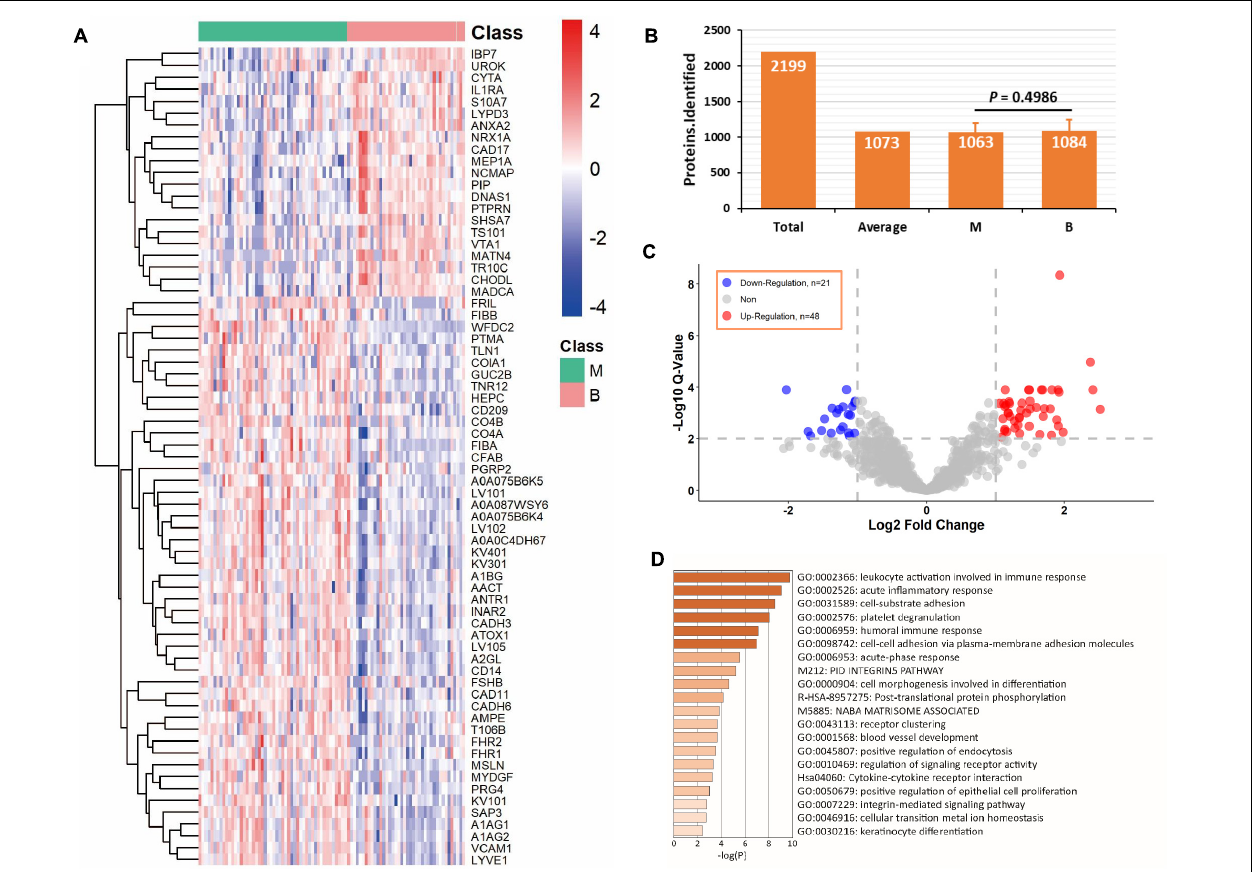
FIGURE 3 | Analysis of differentially expressed proteins in C1 dataset. (A) Differentially expressed proteins in benign and malignant groups with q -value < 0.01 and absolute log2 fold change > 1. (B) Average protein identification numbers in each sample, benign and malignant groups of C1 dataset. (C) Volcano plot of down-regulation and up-regulation in malignant group. (D) Pathway analysis of the differentially expressed proteins using Metascape web-based platform. *B, benign group; M, malignant